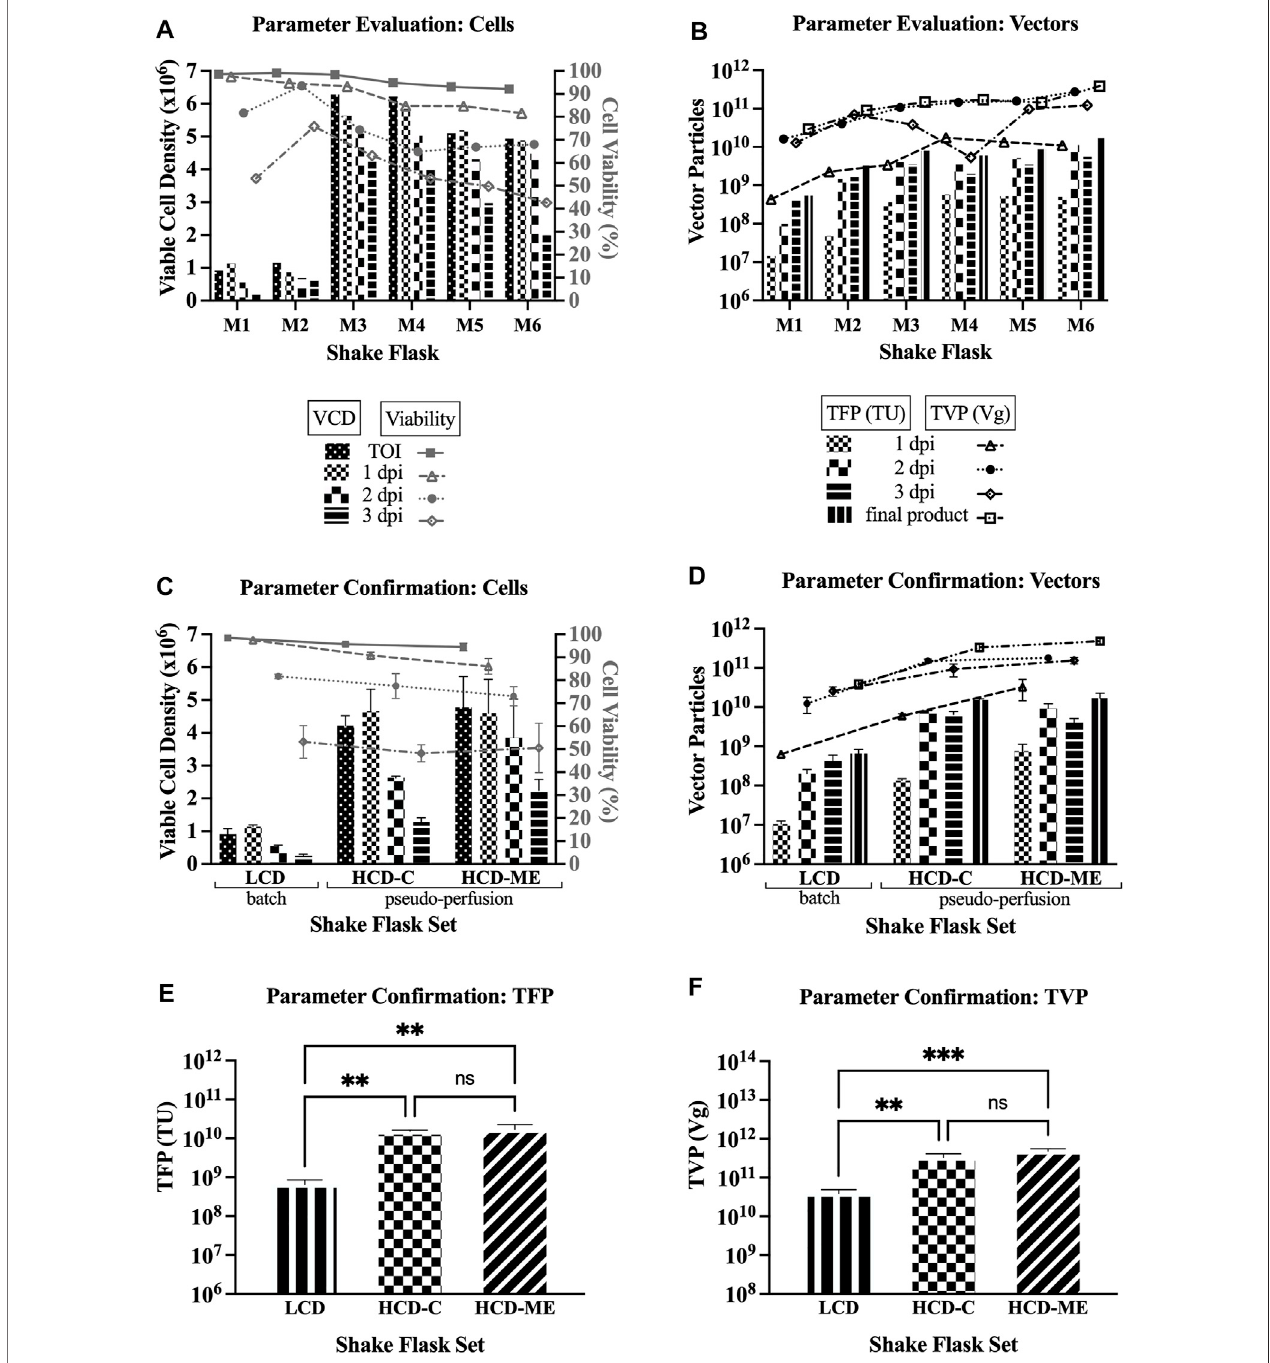
FIGURE1| LVproductionatshake fl askscale.VCD=viablecelldensity;TOI=timeofinduction;dpi=dayspostinduction;LCD=lowcelldensityattheTOI;HCD- C = high cell density at the TOI, obtained by one-step concentration; HCD-ME = high cell density at the TOI, obtained by daily medium exchange; pseudo-perfusion = daily medium exchange after induction to mimic perfusion at bioreactor scale; TFP = total functional particles; TVP = total vector particles; TU = transducing units; Vg = vector genome. 1, 2, and 3 dpi represent sample pools (e.g., 1 dpi includes LVs produced from 0 to 24 h post induction). (A) VCD and cell viability for parameter evaluation (6 single fl asks: M1 = baseline conditions: LCD, batch, no feed; M2 = LCD, pseudo-perfusion; M3 = HCD-C, feed; M4 = HCD-ME, feed; M5 = HCD-ME, pseudo-perfusion; M6 = HCD-ME, pseudo-perfusion, feed). (B) TFP and TVP for parameter evaluation ( fl asks M1-M6). (C) VCD and cell viability for parameter con fi rmation (3 fl asks per set x 3 sets: LCD baseline conditions; HCD-C + pseudo-perfusion + feed; HCD-ME + pseudo-perfusion + feed; values are shown as mean +SD). (D) TFPandTVPforparametercon fi rmation( n =3perset,valuesareshownasmean+SD). (E) StatisticalanalysisofTFPusingone-wayANOVA – adjusted p -value forLCDvs.HCD-Cis0.0045,LCDvs.HCD-MEis0.0024,andHCD-Cvs.HCD-MEis0.7772. (F) StatisticalanalysisofTVPusingone-wayANOVA – adjusted p -valuefor LCD vs. HCD-C is 0.0024, LCD vs. HCD-ME is 0.0003, and HCD-C vs. HCD-ME is 0.0532.